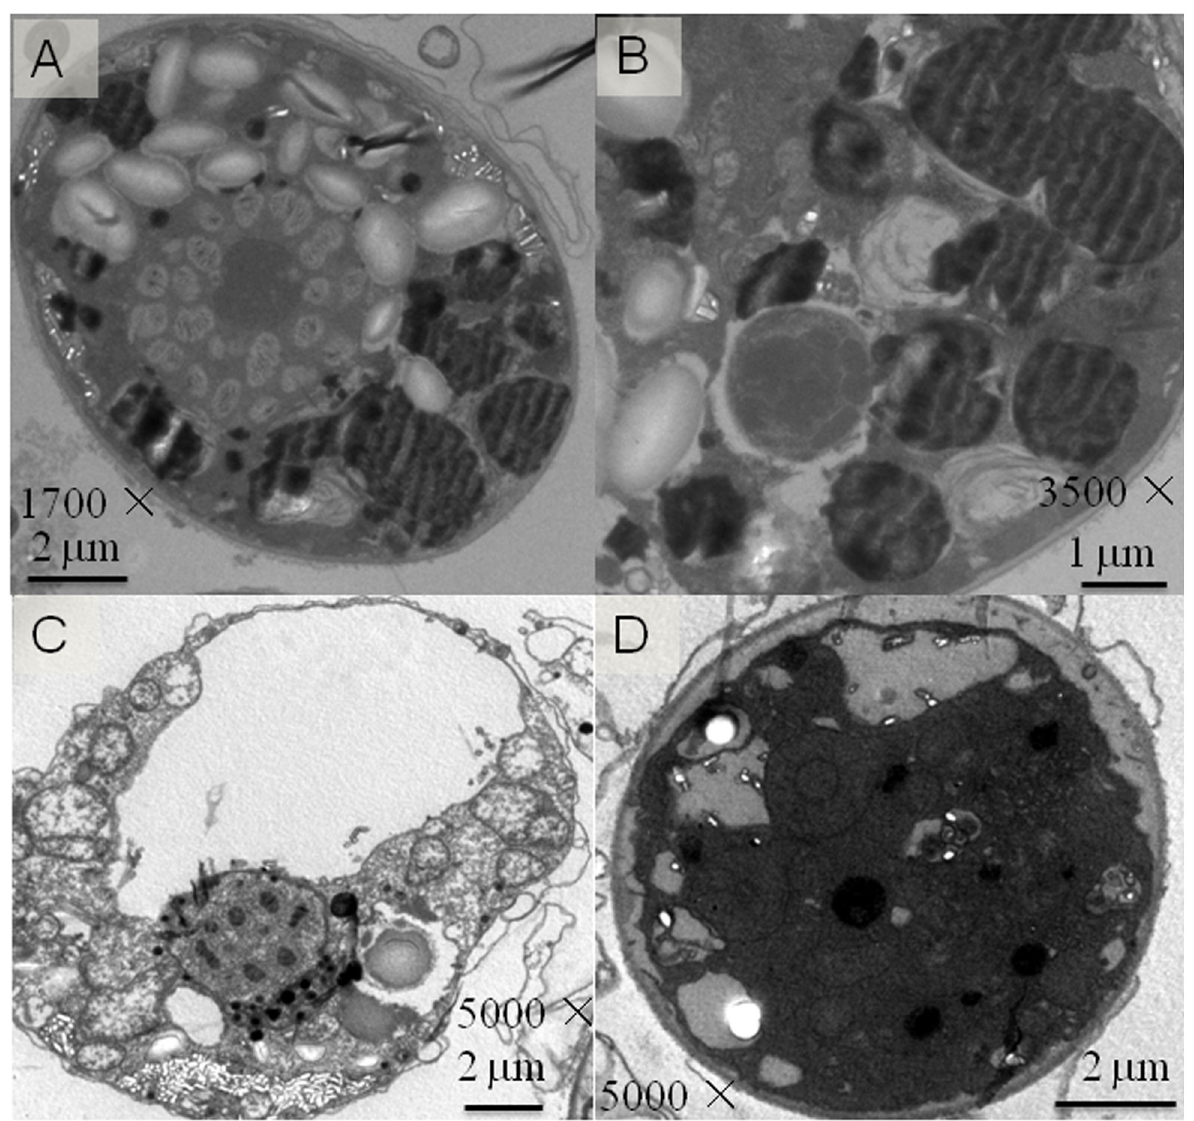
Fig 7. Transmission electron micrograph of C . cohnii cells. Microalga cells were grown on seawater based GYE containing glucose and yeast extract ( A , B ) or RMH-molasses medium composed of the meal hydrolysate and waste molasses ( C , D ) for 7